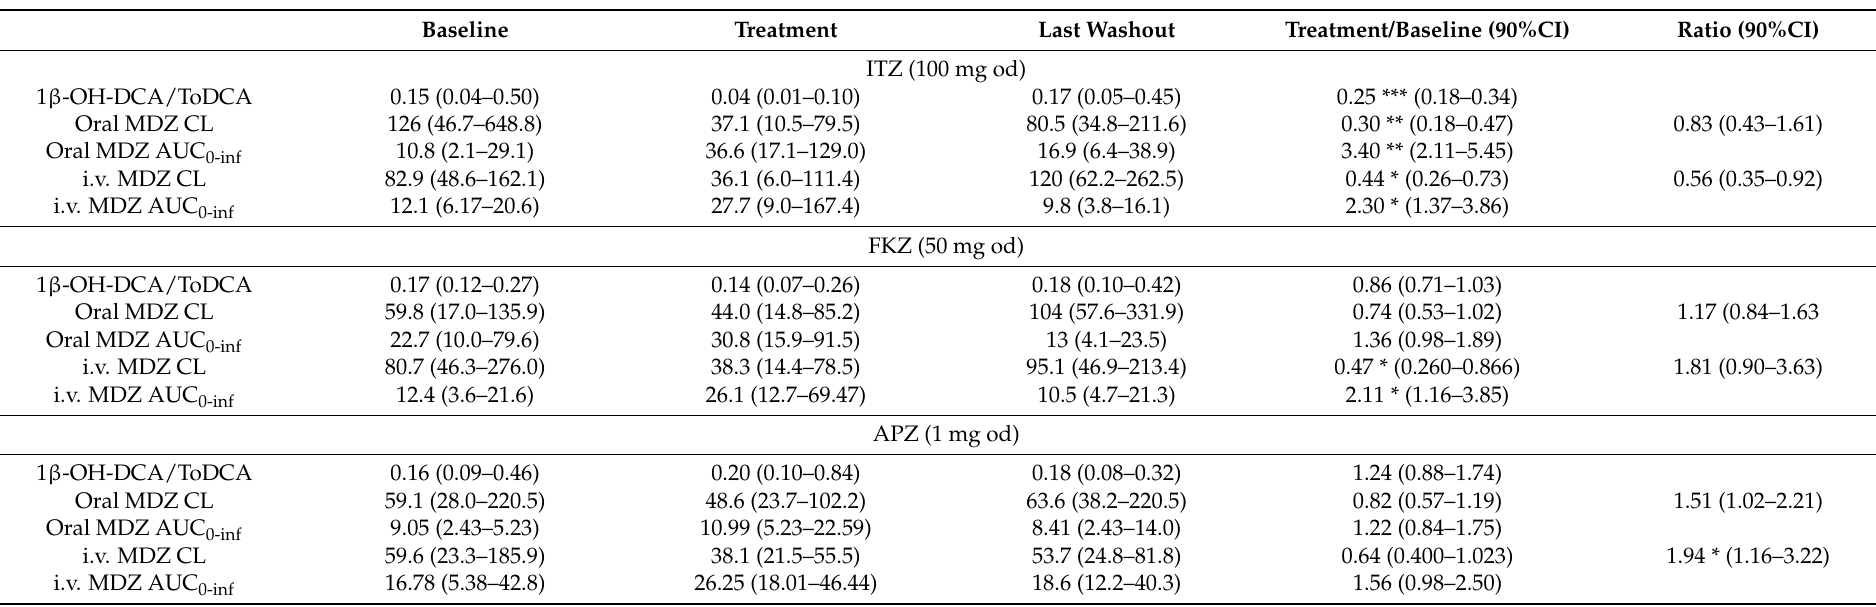
Table 2. Endogenous and exogenous CYP3A markers in men before and after the repeated administration of ITZ/FKZ/APZ, including ratios of treatment/baseline.